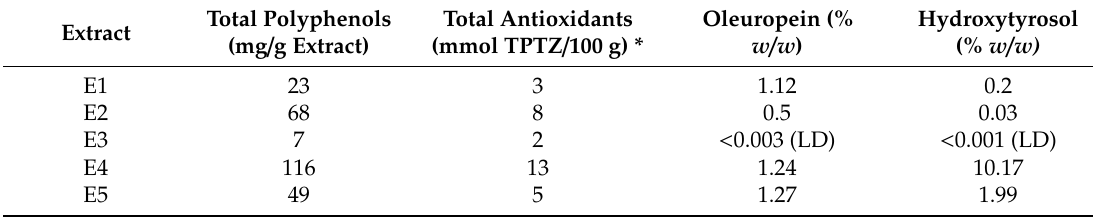
Table 3. Characteristics of the olive aqueous extracts used.